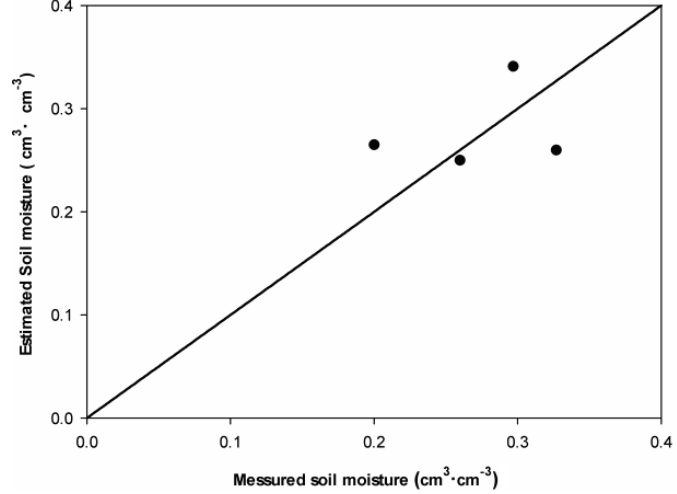
Figure 6. Comparison between soil moisture from the retrieval model and the measurements in the Yingke oasis